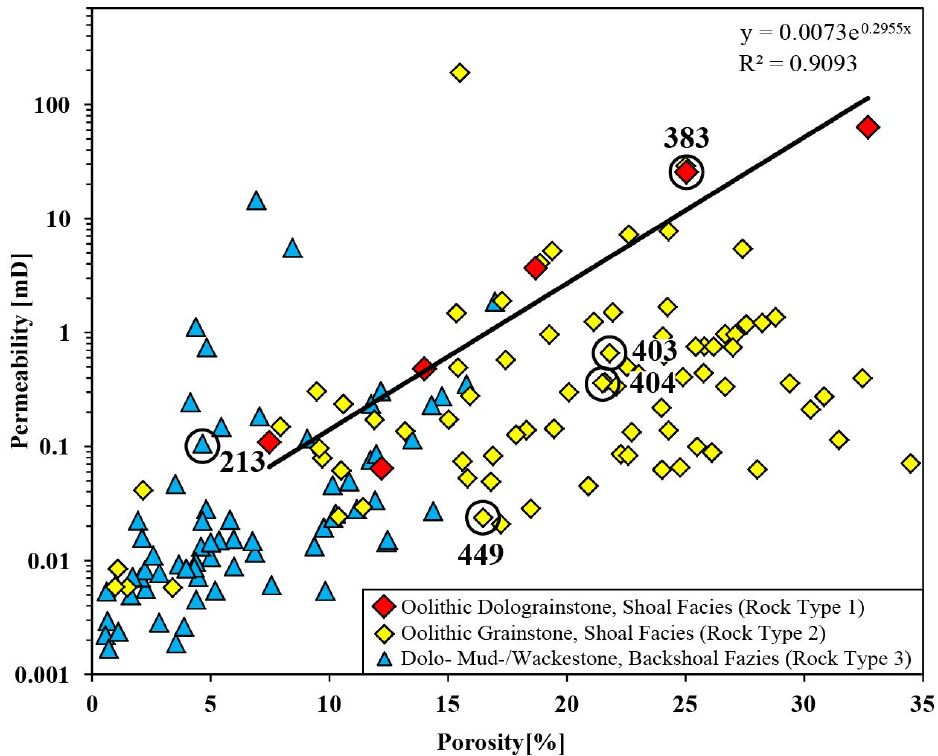
Figure 17. Porosity-permeability-crossplot of 149 carbonate samples from the Khuff-Formation. Lithofacies oolitic dolograinstone, oolitic grainstone, and mud-/wackestone are shown in red, yellow and blue, respectively. Analyzed samples are indicated by their numbers. The regression and its coefficient of determination ( R 2 ) of dolograinstone shoal samples (Rock Type 1) are indicated.